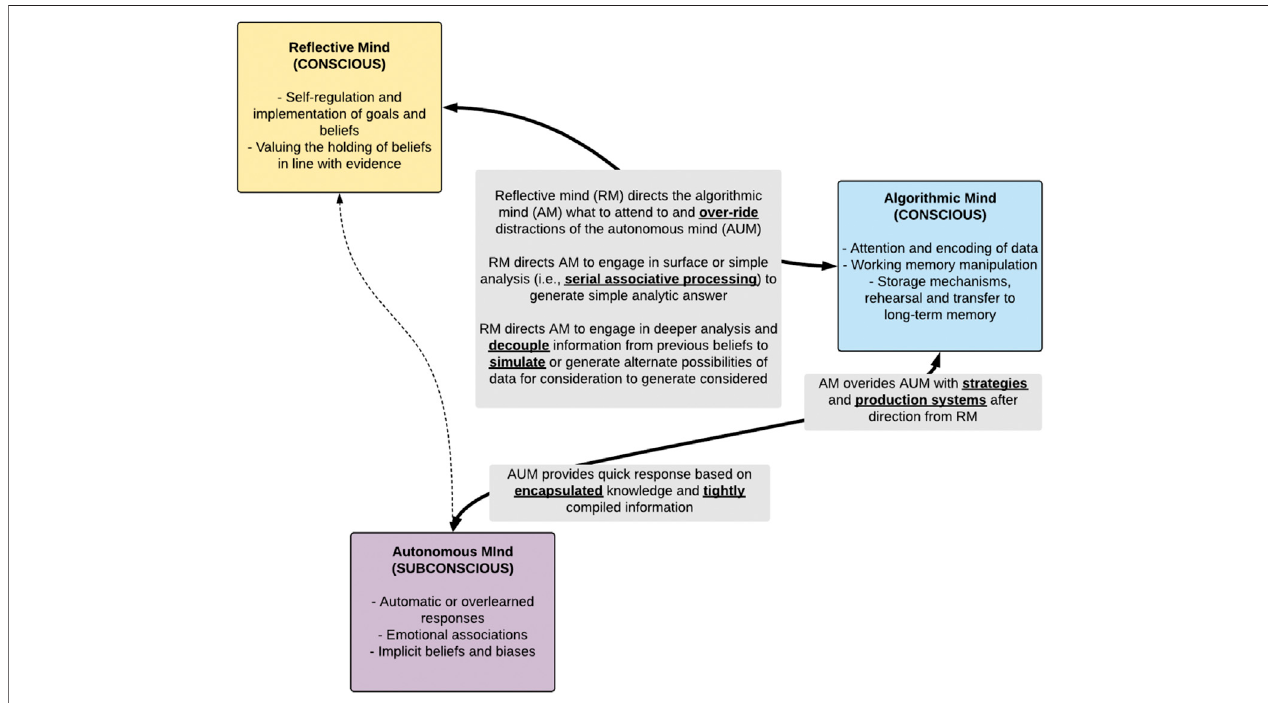
FIGURE 2 | Adapted tripartite model (Stanovich and Stanovich, 2010) to illustrate the connections among three different aspects or minds integral to human